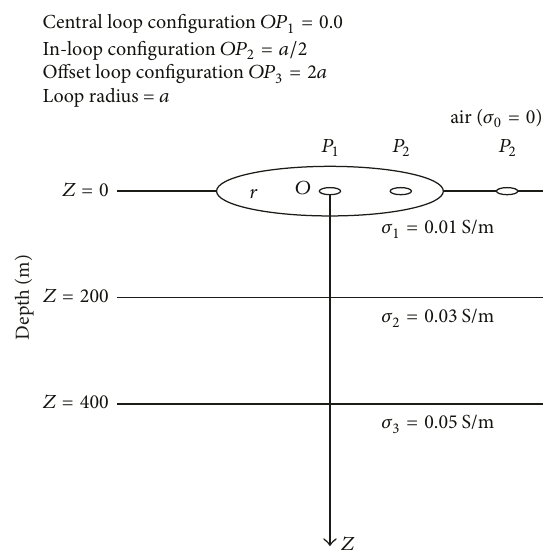
Figure1:Schematicdiagramshowingallthepossibleconfigurations of large loop TEM system over a 3-layer earth model.